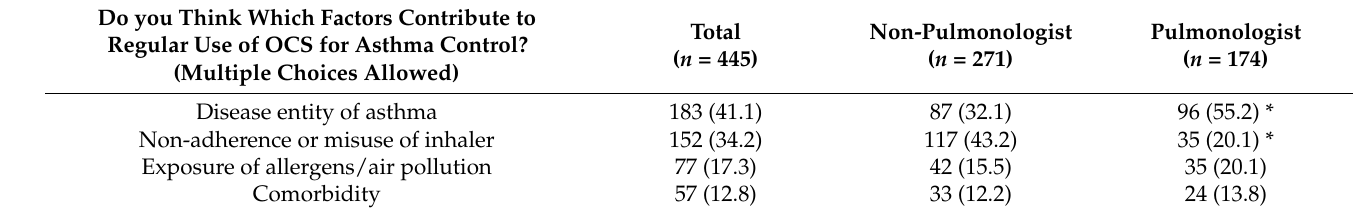
Table 2. Differential response regarding factors contributing to regular use of oral corticosteroids between pulmonologists and